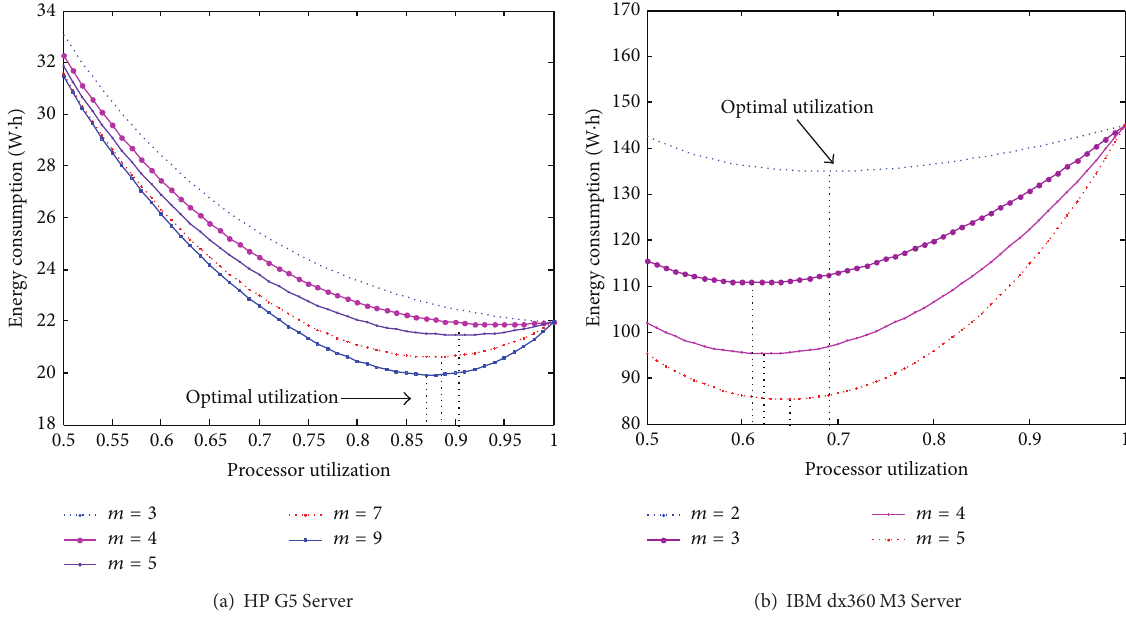
Figure 4: Optimal frequency to reduce